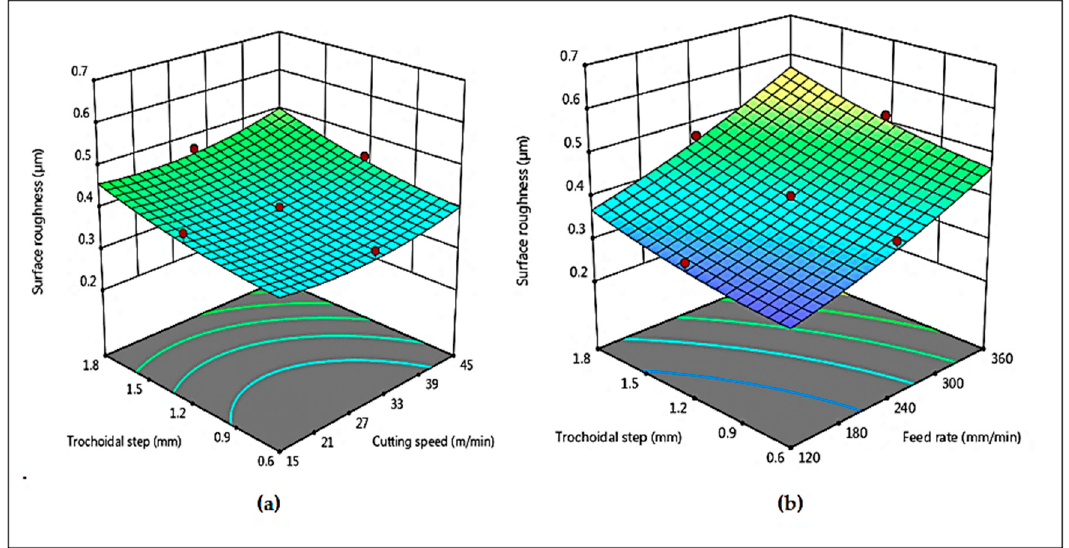
Figure 8. Combined effects of ( a ) v c and s tr on R a ( b ) v f and s tr on R a .